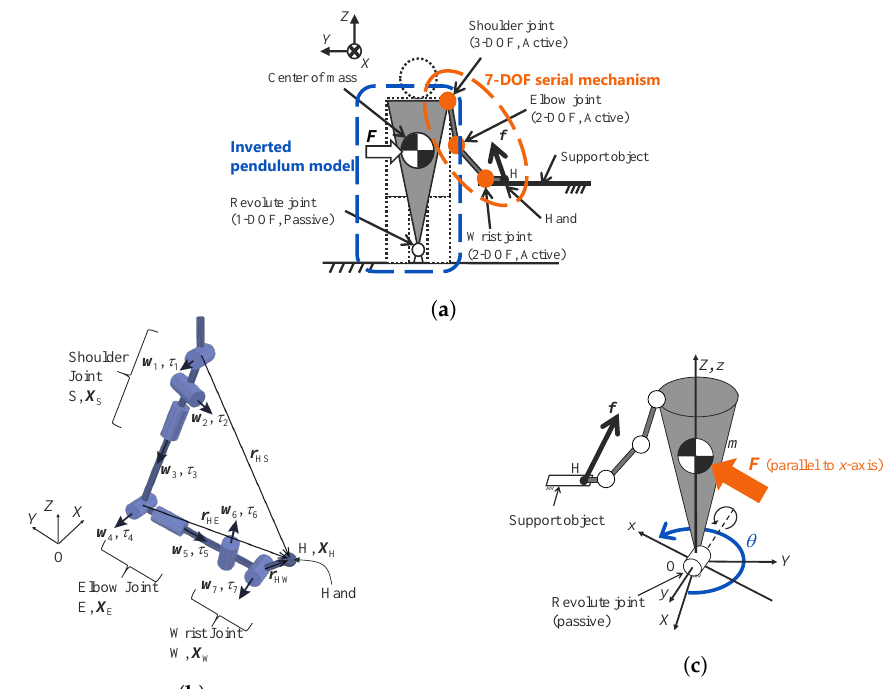
Figure 4. Serial mechanism with 7-DOF and inverted pendulum as human model adapted from [8]. ( a ) overview; ( b ) serial mechanism with 7-DOF; and, ( c ) inverted